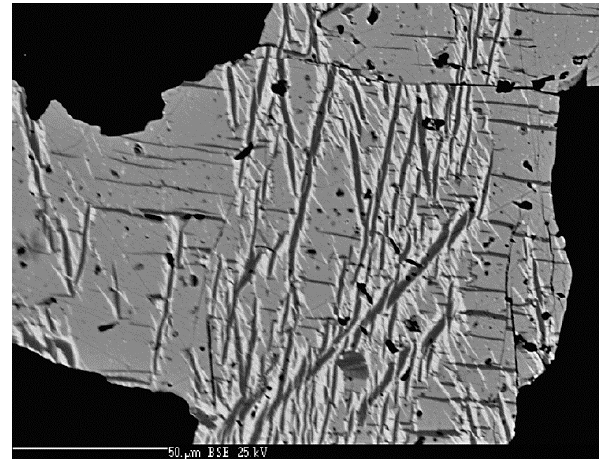
Figure 16. Brodtkorbite aggregates (grey) partly disintegrated to umangite (dark grey) and tiemannite (white). BSE photo. P ř íbram, a dump of shaft 16. Photo by J. Sejkora.